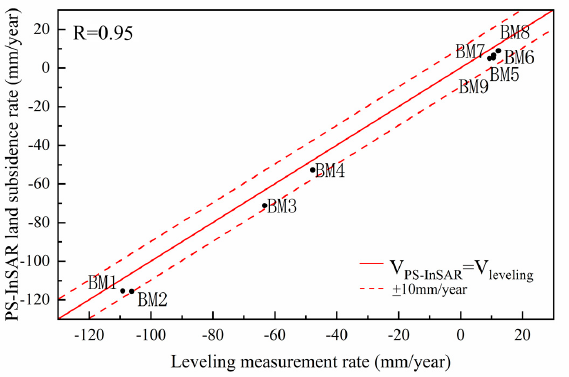
Figure 13. Comparisons of PS-InSAR technique obtained land subsidence rates and leveling measurement rates from 2014 to 2016. The location of benchmarks is marked as “BM1-BM9” (see Figure 2).